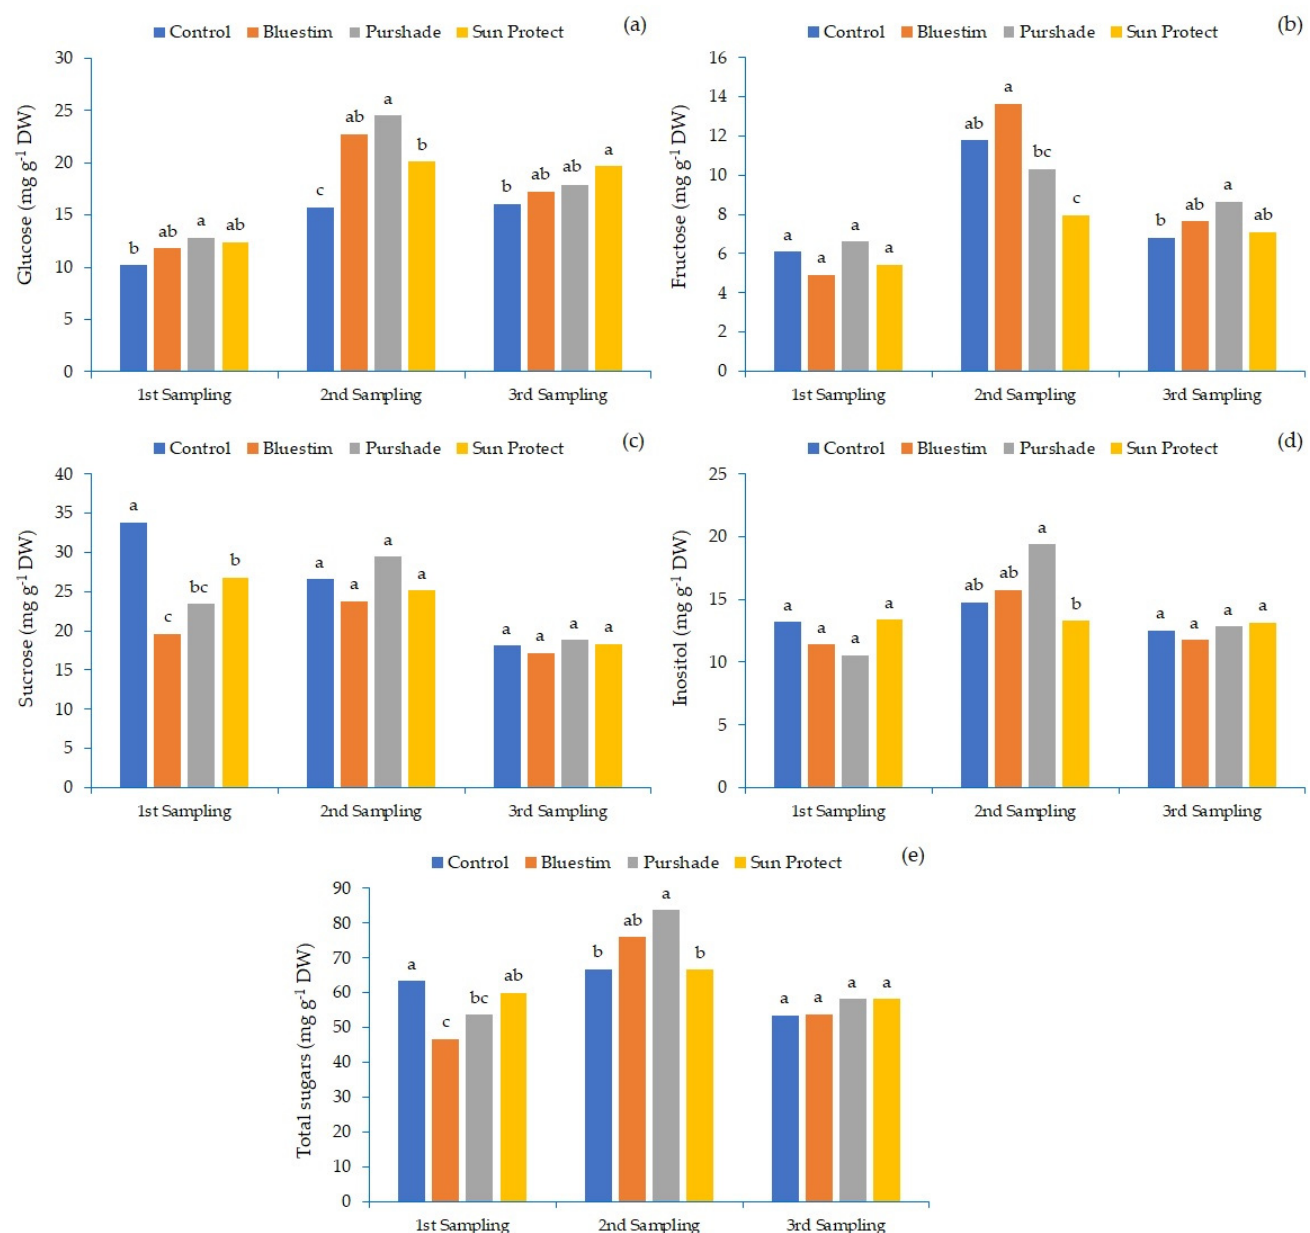
Figure 3. Effects of the alleviating products on kiwifruit leaf carbohydrate concentration ( a ) sucrose, ( b ) fructose, ( c ) glucose, ( d ) inositol, and ( e ) total sugars are expressed as mg g − 1 D.W., during the first (on August 7th), second (on August 20th), and third (on September 21st) sampling events. Different letters above each column under the same sampling event denote statistically significant differences among the treatments according to Tukey’s HSD multiple range test at α =